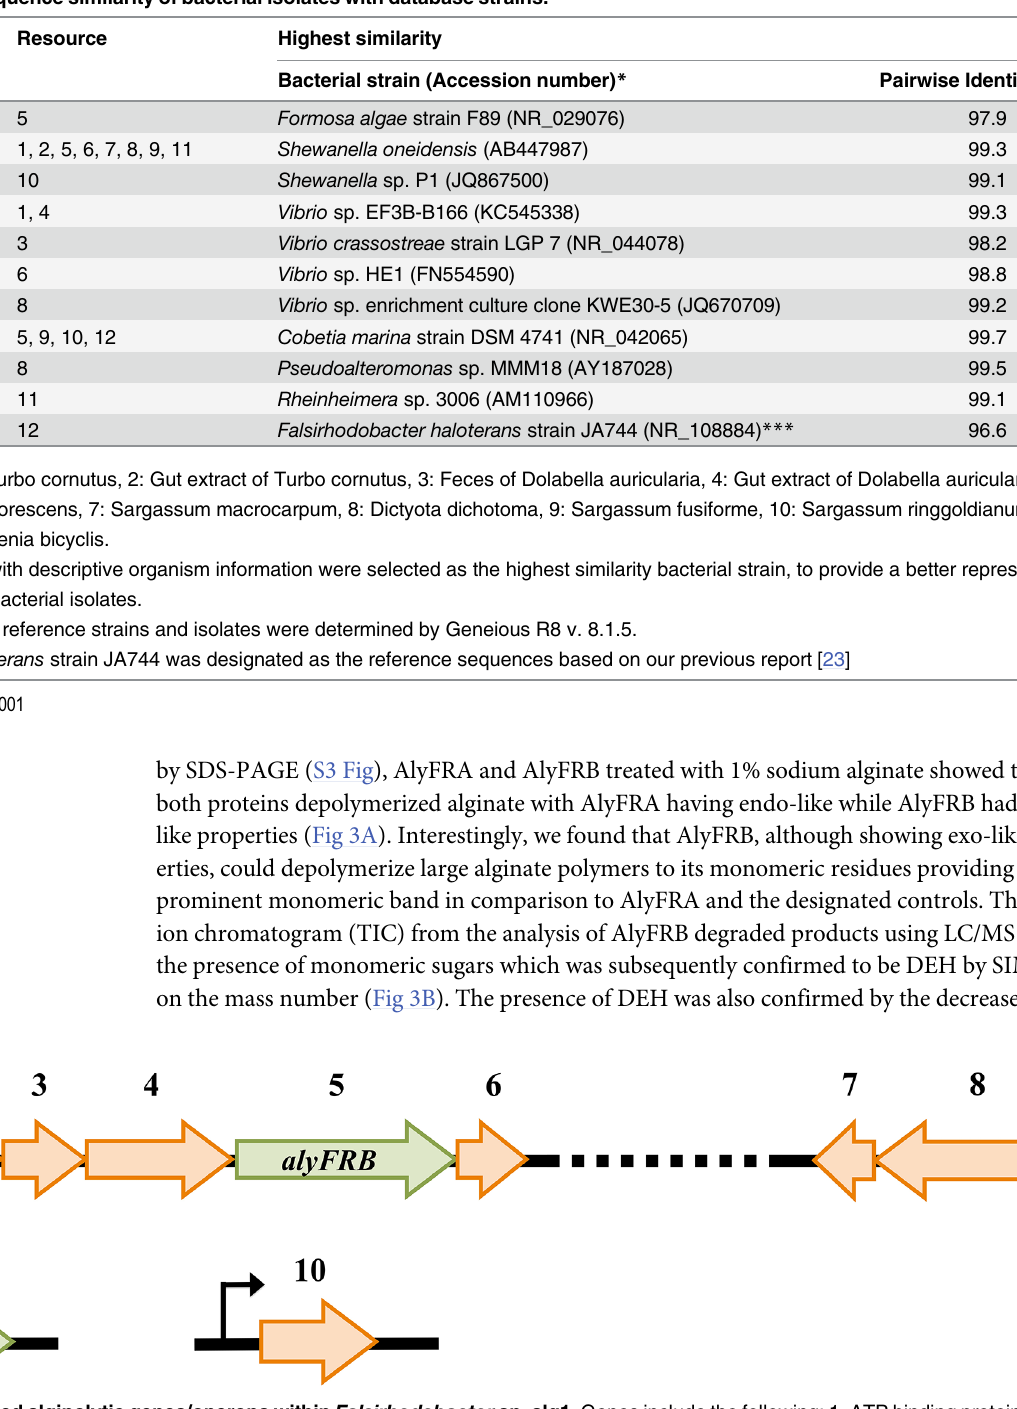
Fig 2. Validated and predicted alginolytic genes/operons within Falsirhodobacter sp. alg1. Genes include the following: 1, ATP binding protein UgpC; 2, ABC-type polysaccharide transport system; 3, ABC transporter permease CDS; 4, ABC transporter, substrate binding protein; 5, oligo alginate lyase CDS ( alyFRB ); 6, acetoin (diacetyl) reductase CDS (DehR-like); 7, 4-hydroxy-2-oxoglutarate aldolase (KdpgA-like); 8, phosphogluconate dehydratase; 9, alginate lyase precursor CDS ( alyFRA ); 10, 2-dehydro-3-deoxygluconate kinase (KdgK-like). Orange arrows and green arrows indicate predicted and validated genes respectively. Dotted lines indicate that the operon with the alyFRB gene and the operon with the KdpgA-like aldolase were located on the same contig with approximately 43 kbp nucleotides apart. Operons and standalone genes were determined by the FGENESB prediction